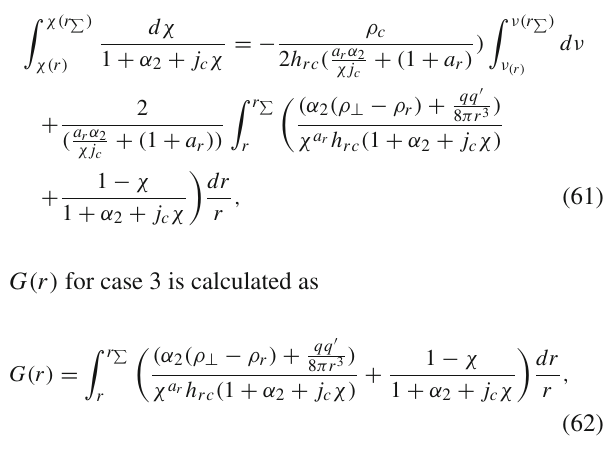
(cid:10) χ( r (cid:7)